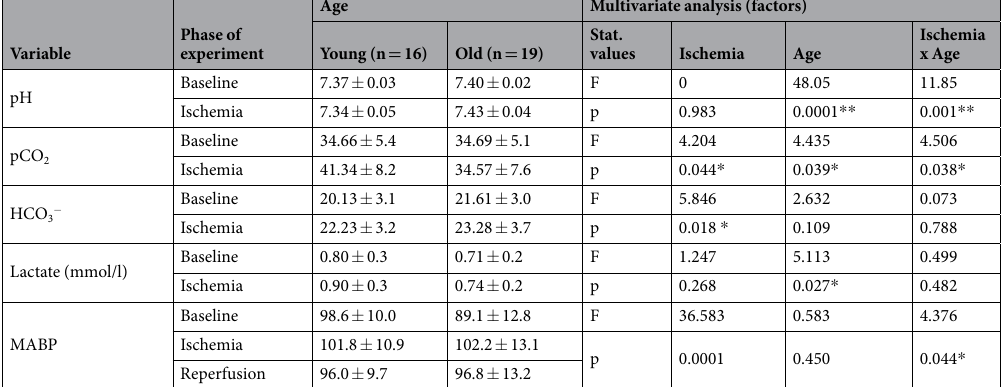
Table 1. Obtained values and statistical evaluation of arterial blood pH, and the level of metabolites relevant for pH adjustment in arterial blood, and mean arterial blood pressure (MABP). Data from both the Electrophysiology and Imaging series of experiments are shown and are given as mean ± stdev. Level of significance is given as * p < 0.05 and ** p <